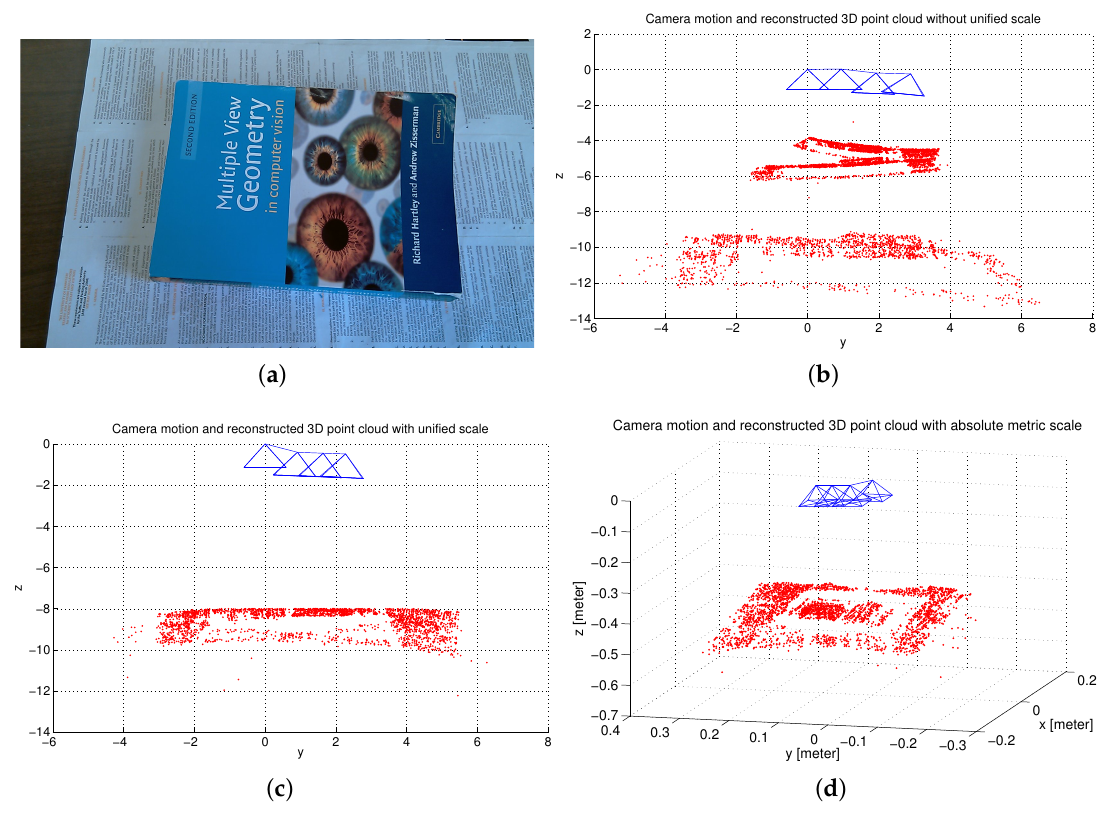
Figure 18. Experimental illustrations for scale adjustment and estimation. ( a ) original frame; ( b ) camera motion and 3D reconstructed point cloud without unified scale; ( c ) camera motion and 3D reconstructed point cloud with unified scale; ( d ) camera motion and 3D reconstructed point cloud with metric